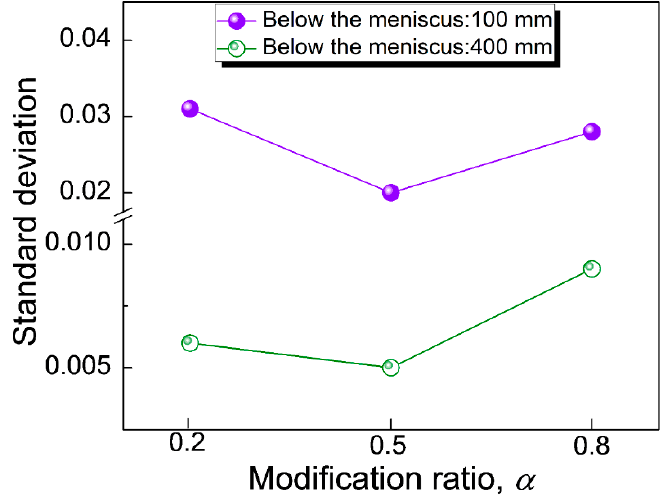
Figure 6. Effect of nonsinusoidal oscillation on the thickness of liquid film at different positions below the meniscus: ( a ) 100 mm and ( b ) 400 mm.